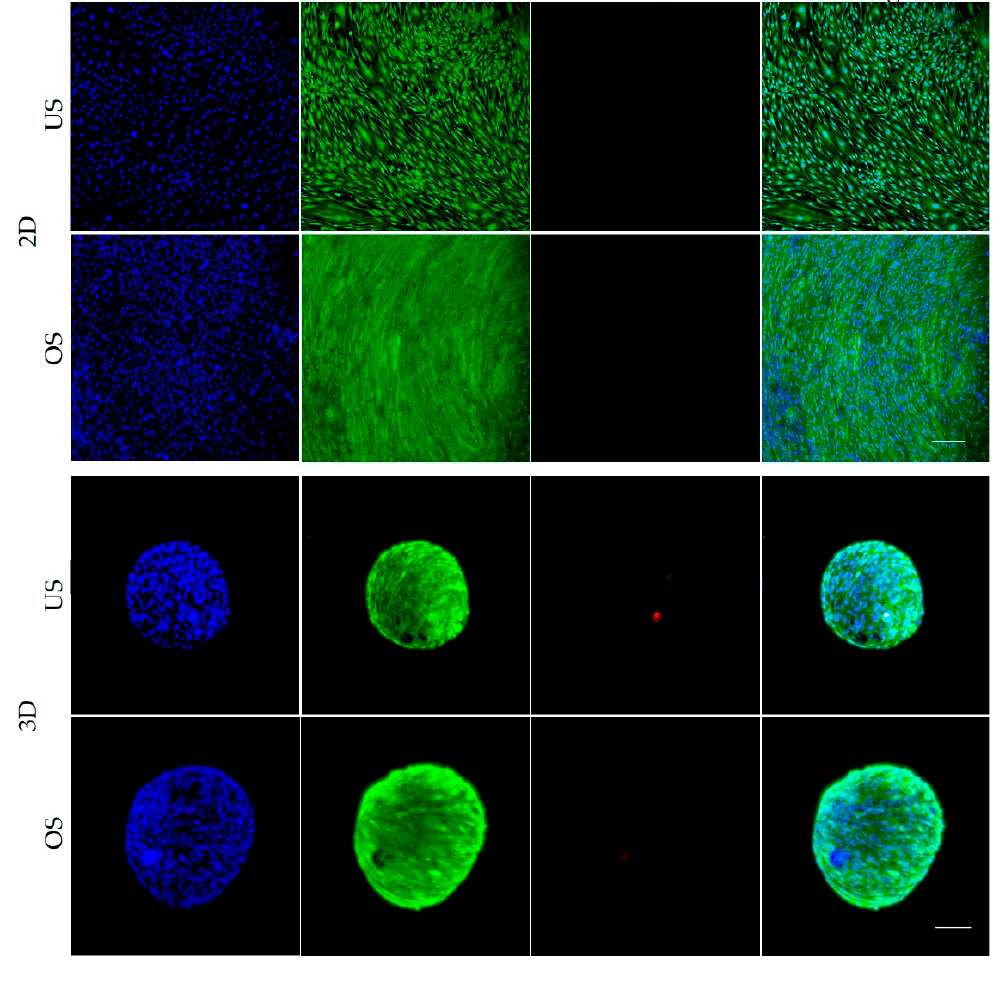
Figure 3. Live/dead staining of unstimulated (US) or osteogenically stimulated (OS) adMSC in 2D culture ( top panels) and 3D spheroid culture after 35 days ( bottom panels) (exemplary images of n = 4, LSM 780, Zen black software, overlay of Z-stacks, green: live cells, red: dead cells, blue: nuclei; scale bar: 200 µm).